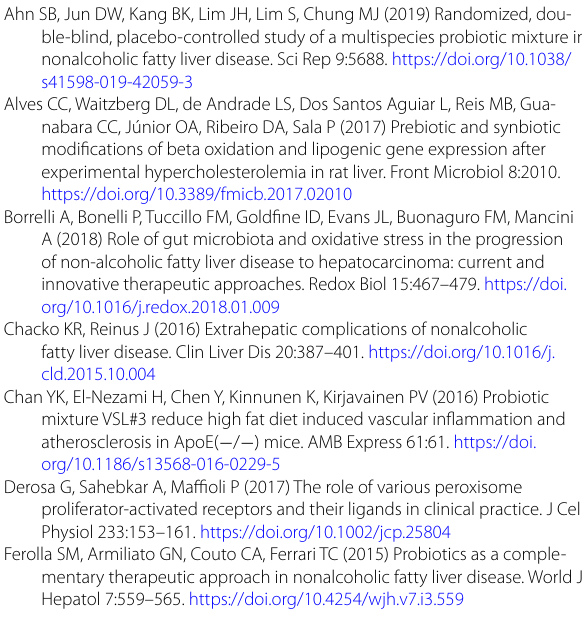
Additional file 1: Table S1. The specific primer sequences of genes of interest. Figure S1. Western blot analysis of hepatic TLR4 and TLR9. The representative picture is one from three independent